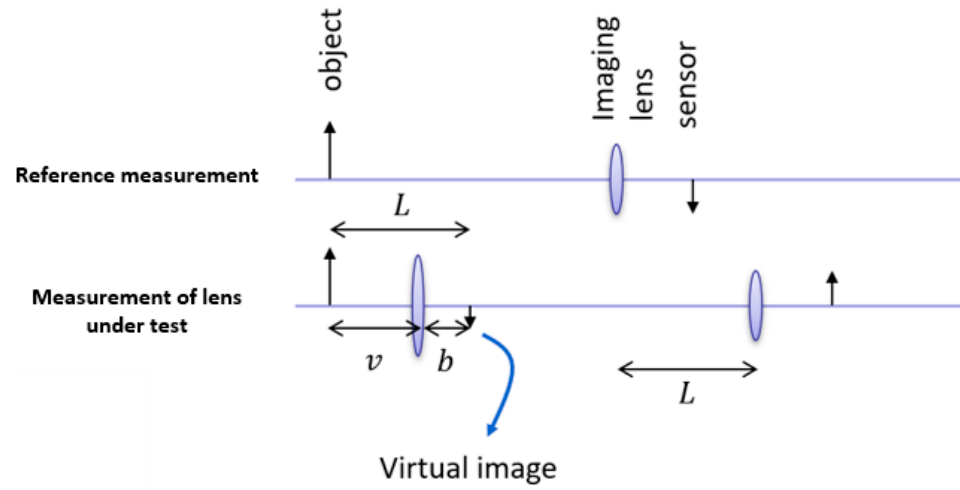
Figure 6. Determination of the focal distance of human lenses.